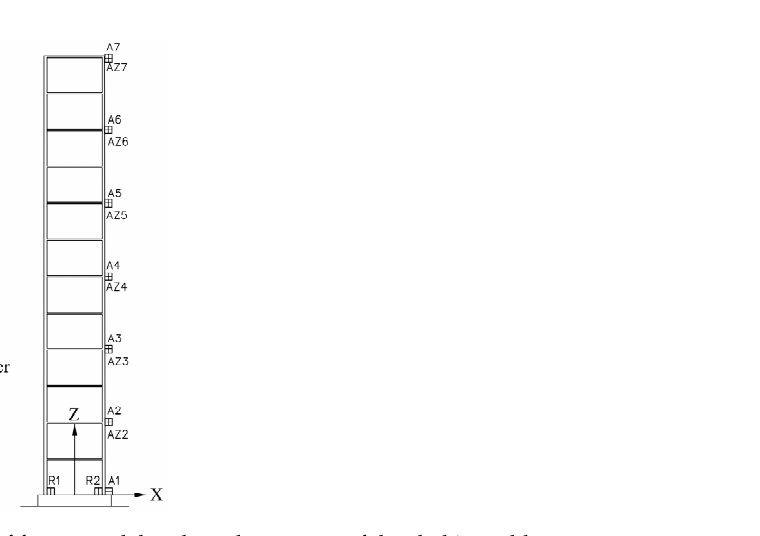
Figure 7. View of frame model and accelerometers of the shaking table test.